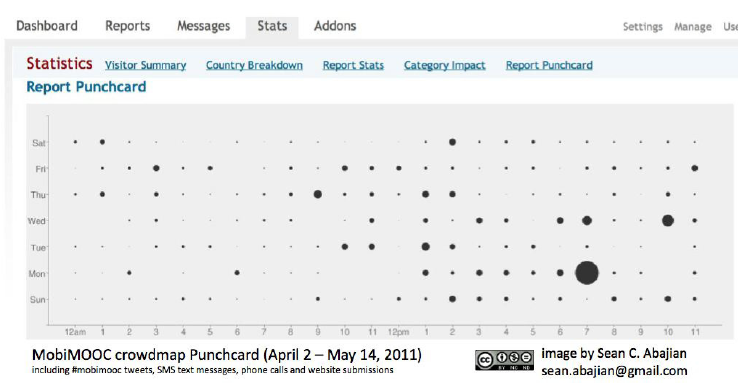
Figure 1 . MobiMOOC crowdmap punch card, including #mobimooc tweets. Taking into account the diversity of MobiMOOC interactions, one can see it or any MOOC as a complex system. In the next part of the paper, we analyze the MobiMOOC as a com - plex system with its emerging phenomena and focus on dialogue forming the center of the class’s